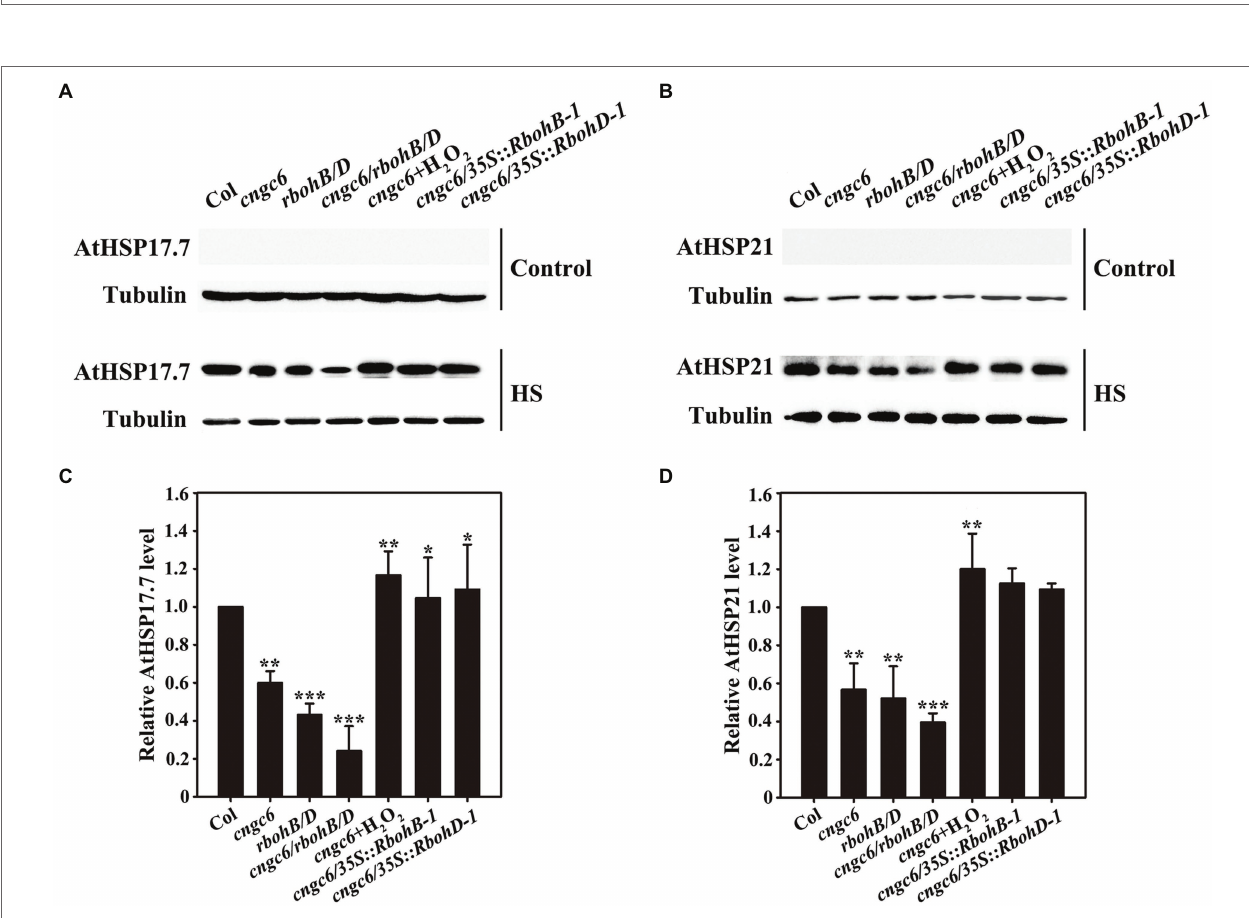
FIGURE 8 | Effects of CNGC6 via H 2 O 2 on AtHSP17.7 and AtHSP21 expression. (A,B) About 10-day-old seedlings grown at 22 ° C were exposed to 37 ° C (HS) or maintained at 22 ° C (Control) for 2 h. Total protein was then extracted, separated by SDS-PAGE, and analyzed by Western blotting. Tubulin was used as an internal control. Three independent experiments were carried out; the results indicate similar trends in protein accumulation. (C,D) The relative HSP17.7 (C) and HSP21 (D) level after HS treatment. The data presented are the means ± SE of measurements taken from three independent experiments and represents the relative intensity of each signal. * p < 0.05, ** p < 0.01, and *** p < 0.001 vs. Col (Student’s t